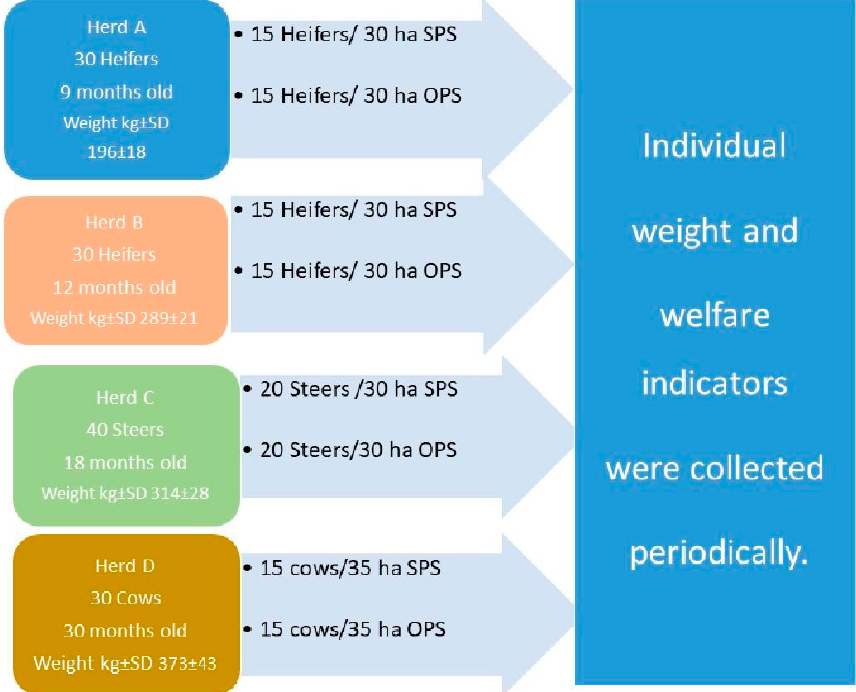
Figure 2. Scheme with a 2 × 2 tree plantation design.